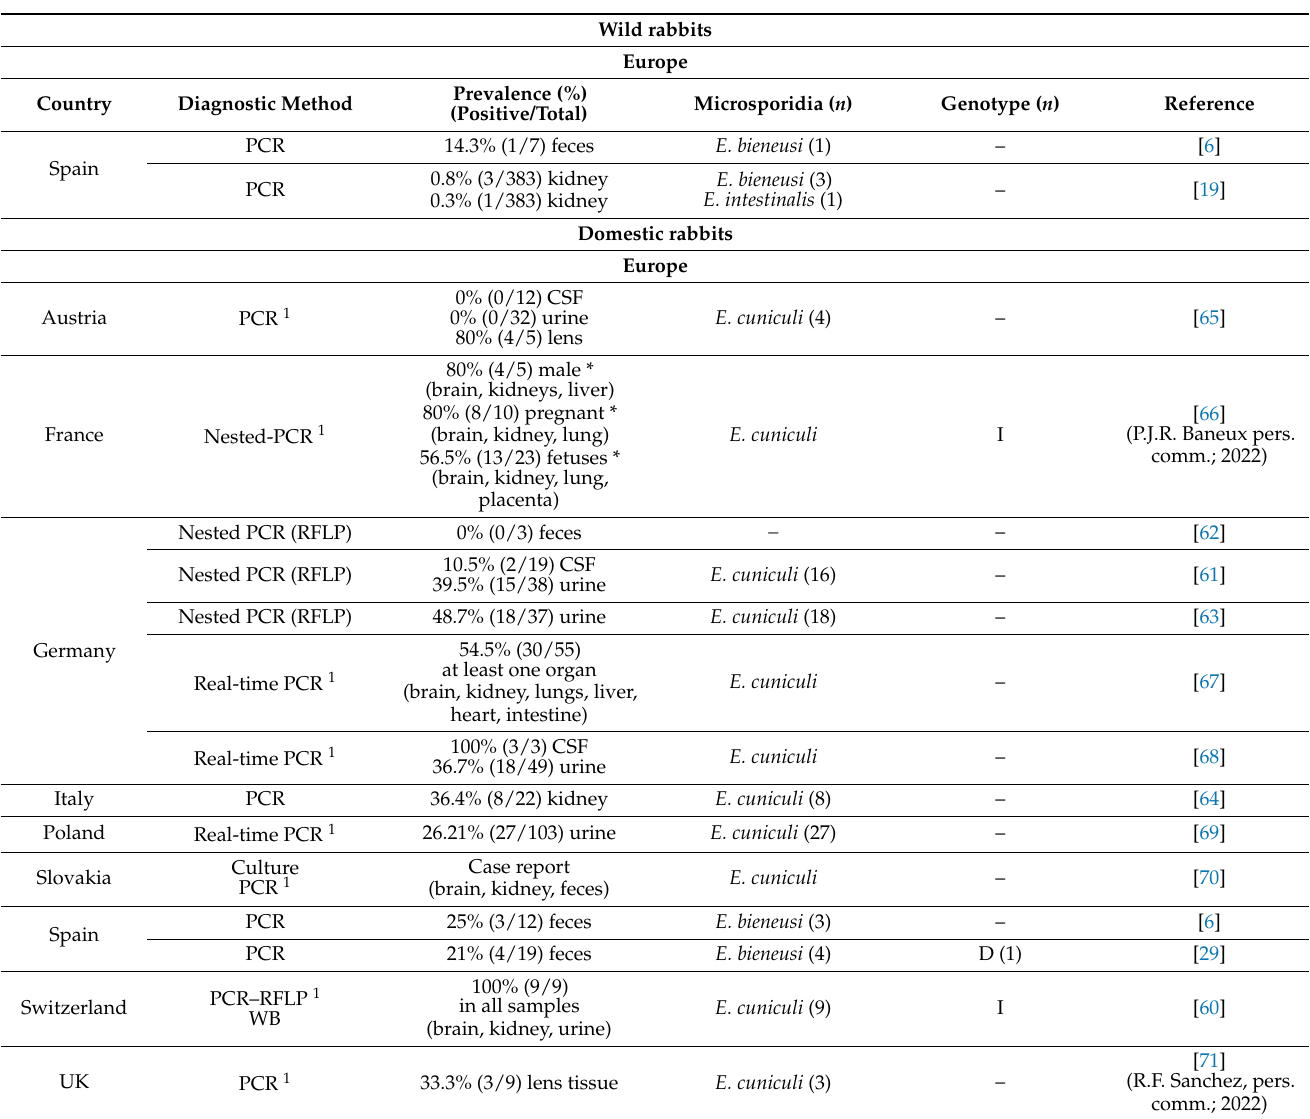
Table 2. Molecular studies of microsporidia in rabbits. Wild